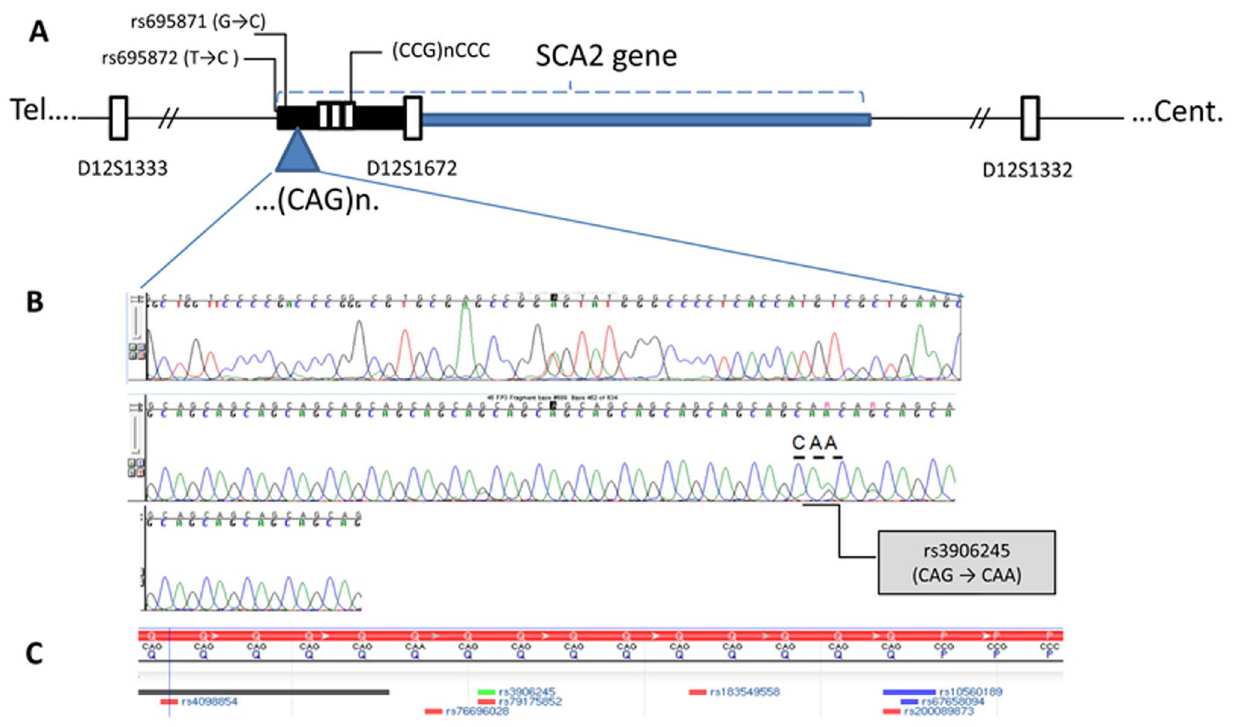
Figure 3. Genetic markers for ATXN2 haplotyping and gene sequencing. A) ATXN2 gene schematic maps and microsatellite, D12S1333 (telomeric at 200 kb from ATXN2 ), D12S1672 (intragenic at exon 1) and D12S1332 (centromeric at 350 kb from ATXN2 ) and SNIPs markers, rs695871 (at 177 bp upstream CAG expansion), rs695872 (at 106 bp upstream CAG expansion) and rs390624 (within the expanded CAG) used for haplotyping cases involved in de novo mutations, the polymorphic (CCG)nCCC/poly-proline adjacent to the CAG expansion is also indicated. B) Sequencing for case II-10, mother of the proband III-16 (25 CAG with only one CAA interruption). C) Relative position for other SNPs situated either within or near the expanded CAG.